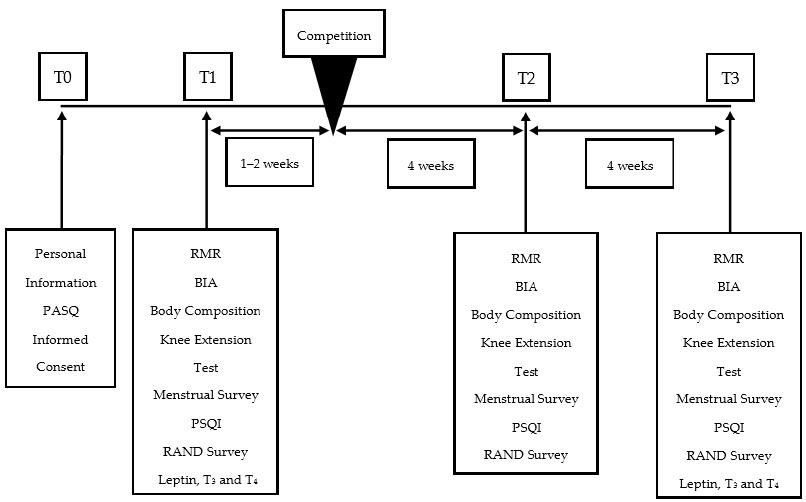
Figure 1. Overview of competitor assessment. RMR: Resting metabolic rate; BIA: Bioelectrical impedance analysis; PSQI: Pittsburgh sleep quality index.